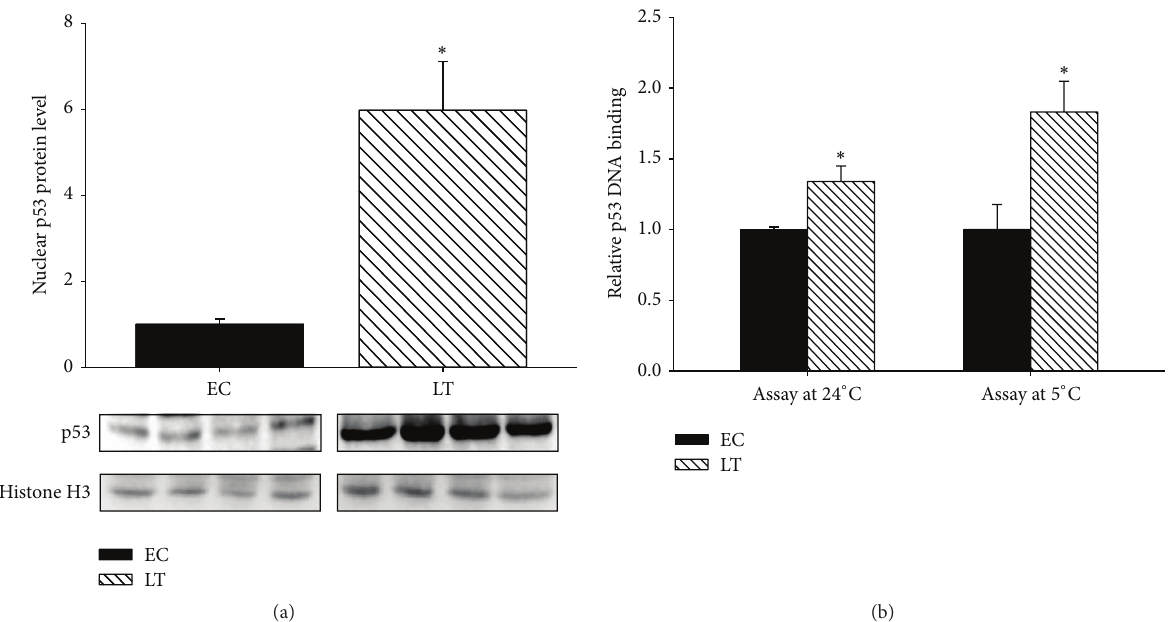
Figure 3: Nuclear regulation of p53 during late torpor. (a) Western blot is shown for nuclear levels of p53 and histone H3 during euthermic control and late torpor. (b) p53 DNA binding activity towards double stranded probe containing p53 consensus binding sequence (5 󸀠 - GGACATGCCCGGGCATGTCC-3 󸀠 ) in control and late torpor nuclear lysates. Data show mean ± SEM, 𝑁 = 4 independent trials on tissues from different animals. ∗ denotes significant statistical difference from EC values, 𝑝 < 0.05 .